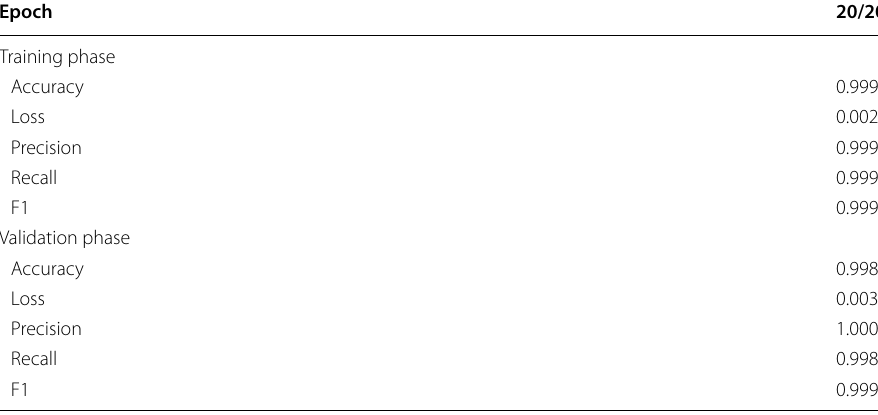
Table 6 Results using Count Vectorizer Count Vectorizer